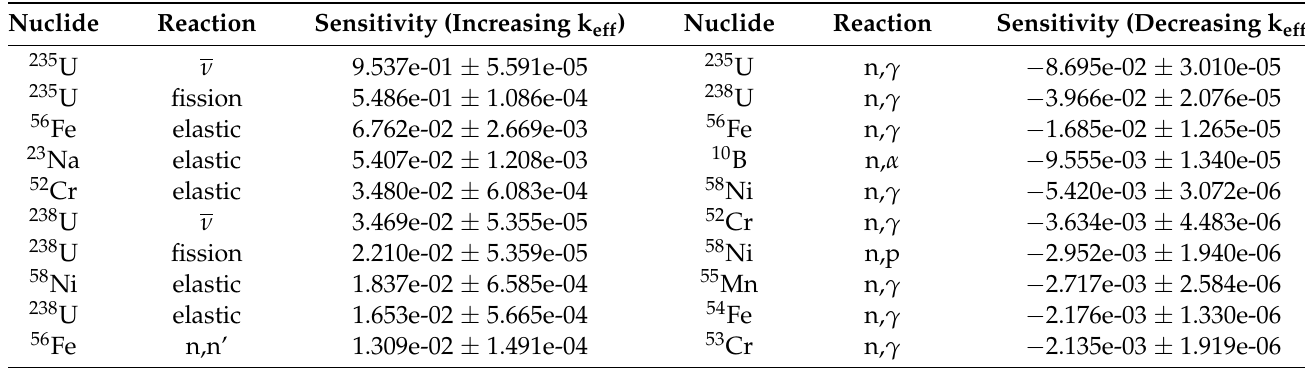
Table 5. EBR-II: top k eff sensitivities (top 10 positive and top 10 negative mixture-, region- and energy-integrated sensitivities, determined with TSUNAMI-CE using ENDF/B-VII.1